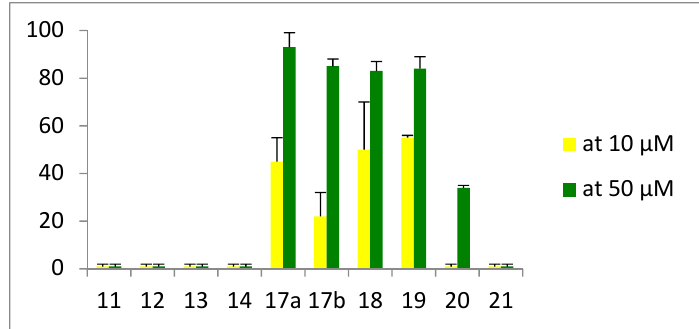
Figure 7. Percentage of cell death (see Supporting Information).